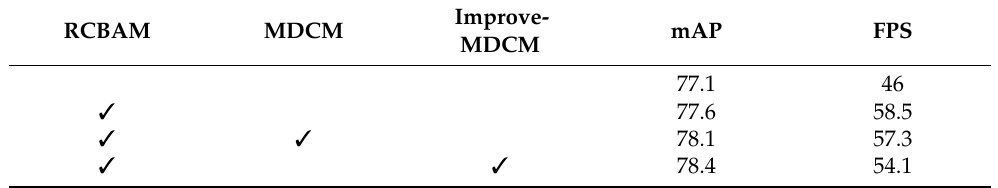
Table 7. Improved SSD model compared with SSD, SSD + RCBAM, and SSD + RCBAM +